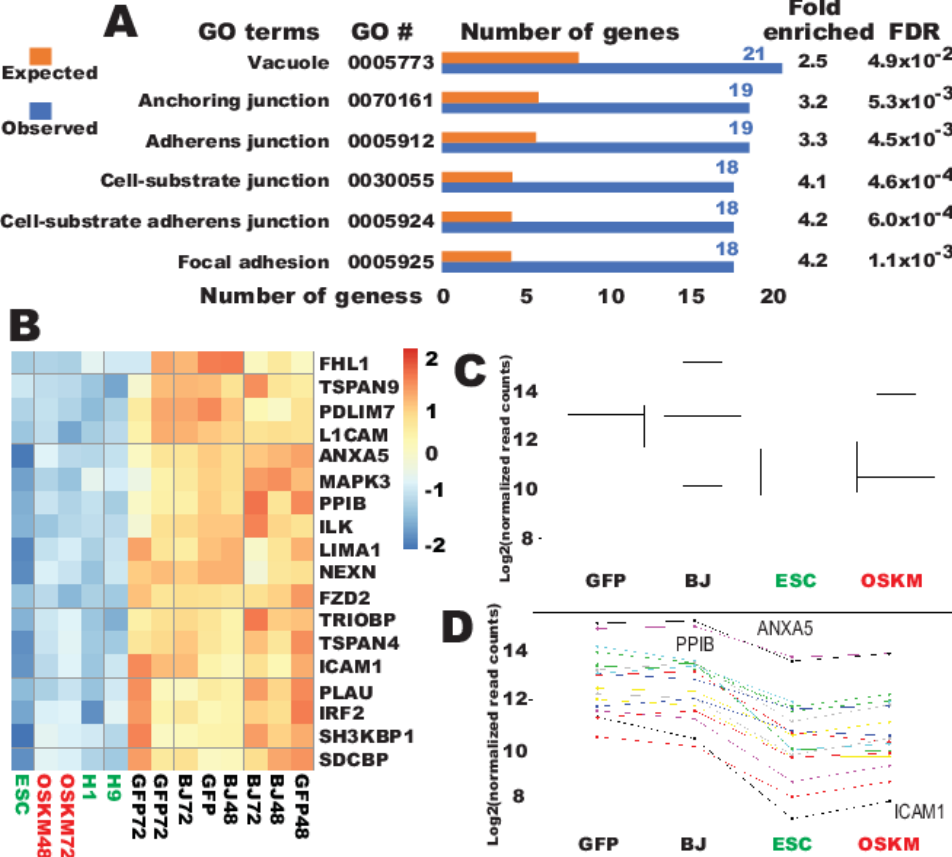
Figure 5. Genes for cellular components of vacuole and focal adhesion were successfully downreprogrammed by OSKM within 48 h. ( A ) Summary of GO analyses with the annotated GO dataset of “cellular component complete”. ( B ) Heat map for the 18 focal adhesion genes successfully downreprogrammed. ( C ) Box plot for data in ( B ). ( D ) Ladder plot for data in ( B ). Each colored line across the samples represent a specific gene.